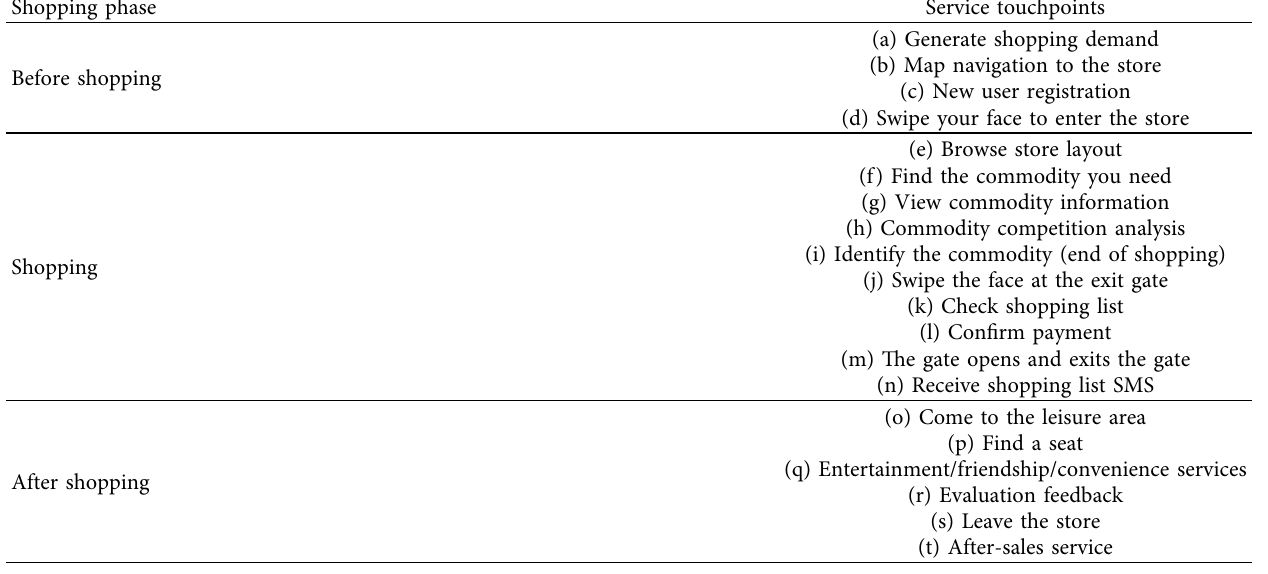
Table 4: Summary of service touchpoints of the convenience store